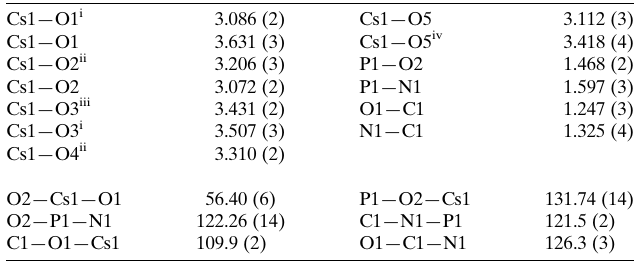
Table 1 Selected geometric parameters (A˚ , (cid:4) ).